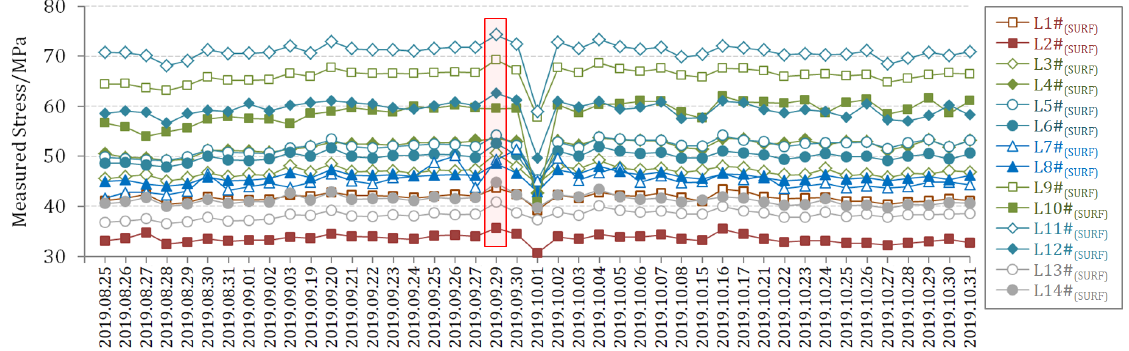
Figure 11. Peak stress detection during test period.